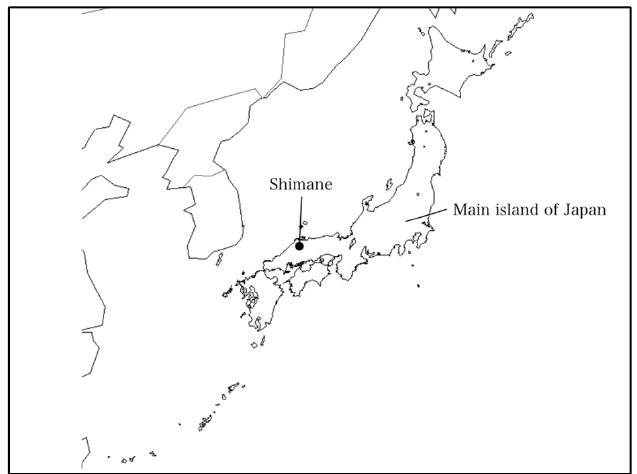
Figure 1. The location of the study setting.